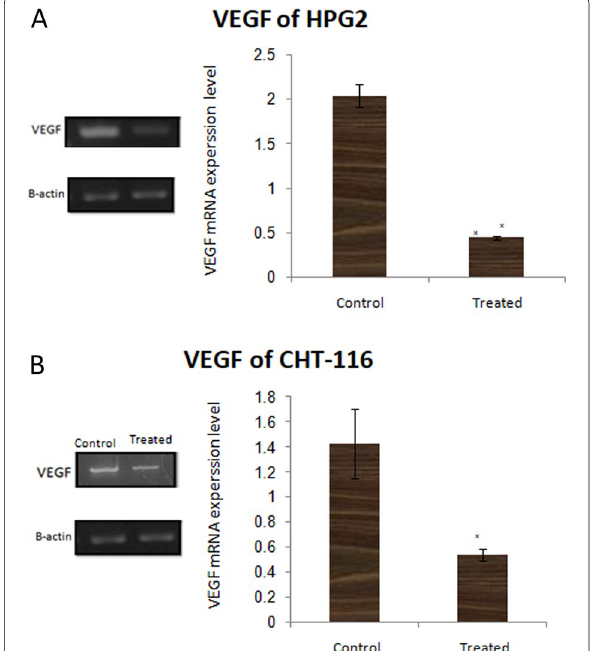
Fig. 9 PCR detected the expression of VEGF in HepG2 and HCT‑116 cells after treatment with NSP where the internal control expressed by the β‑actin gene. In each illustrative experiment data represent means SE performed in triplicate. *represents significantly dissimilar ± results (P < 0.05)